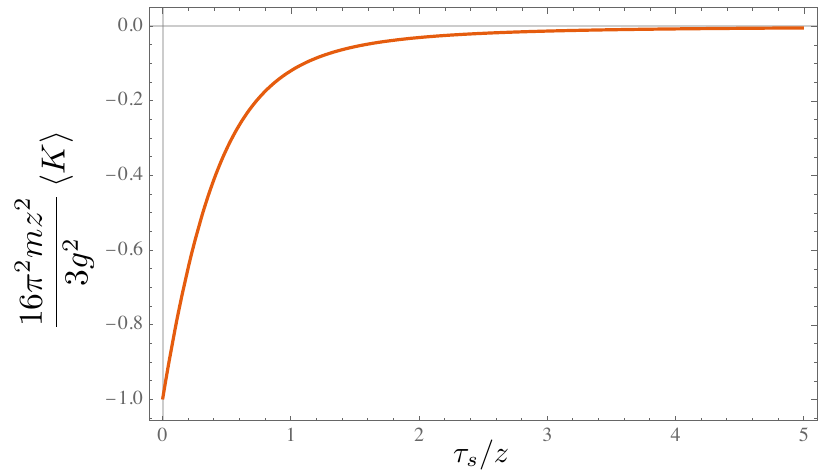
Figure 7 . Vacuum expectation value of the kinetic energy (